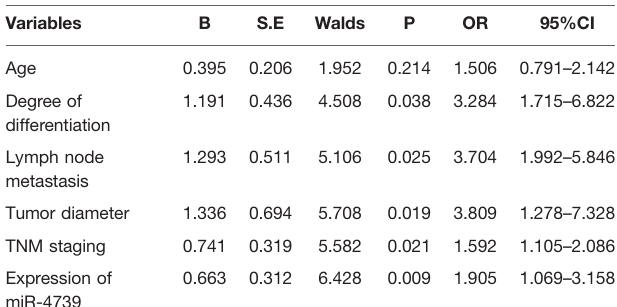
TABLE 4 | Multi-factor analysis assignment table. TABLE 5 | Multivariate analysis of prognosis of patients with